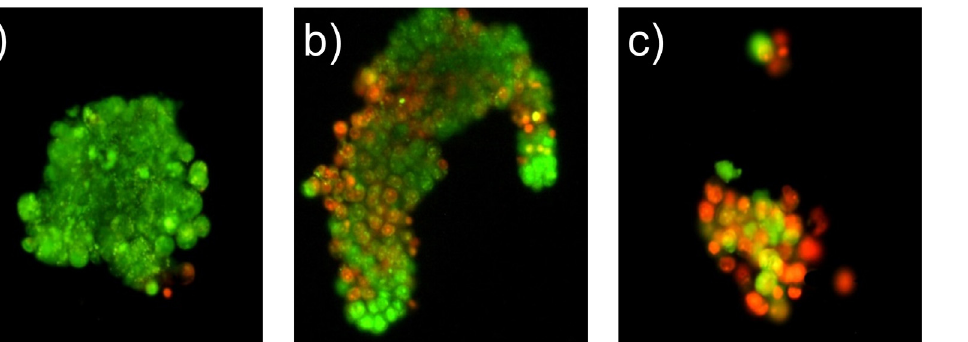
Fig 3. Evaluation of cell mortality with acridine orange/ethidium bromide (AO/EB) staining after exposition to chemotherapeutic agents. AO is a vital dye and stains both live and dead cells. EB penetrates into cells with disrupted cytoplasmic membrane, staining only dead cells. Therefore, viable cells appear uniformly green and dead cells are labelled in orange. a) Low sensitivity (cell mortality 5%). b) Average sensitivity (cell mortality 40%). c) High sensitivity (cell mortality